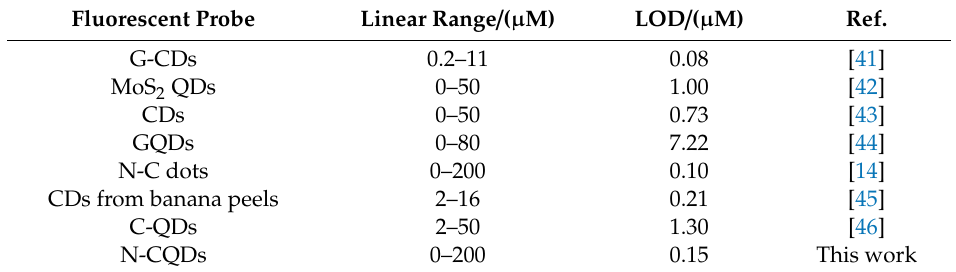
Figure 6. ( a ) Fluorescence emission spectra of N-CQDs in the presence of increasing Fe 3 + ion concentrations (0–500 µ M). ( b ) Nonlinear Stern–Volmer quenching profile of N-CQDs with Fe 3 + ion concentration ranging between 0 and 500 µ M. Right inset shows the linear part of the Stern–Volmer quenching profile with Fe 3 + ion concentration ranging between 0 and 200 µ M. Left inset shows the visible change in the blue photoluminescence intensities of the N-CQDs treated with Fe 3 + ions, excited by UV light with a wavelength of 365 nm. Table 1. Comparison of sensing performance of di ff erent fluorescent probes for Fe 3 + ion